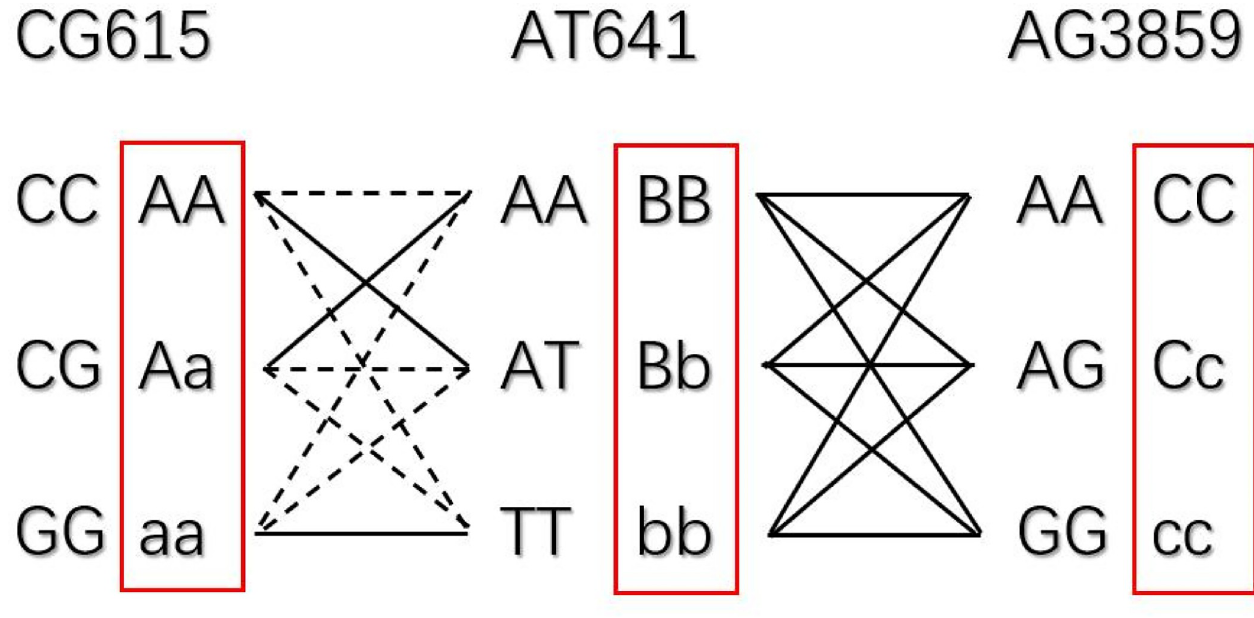
Fig 7. Schematic diagram of genotypes. Dotted lines indicate the possible genotypes that were not observed.